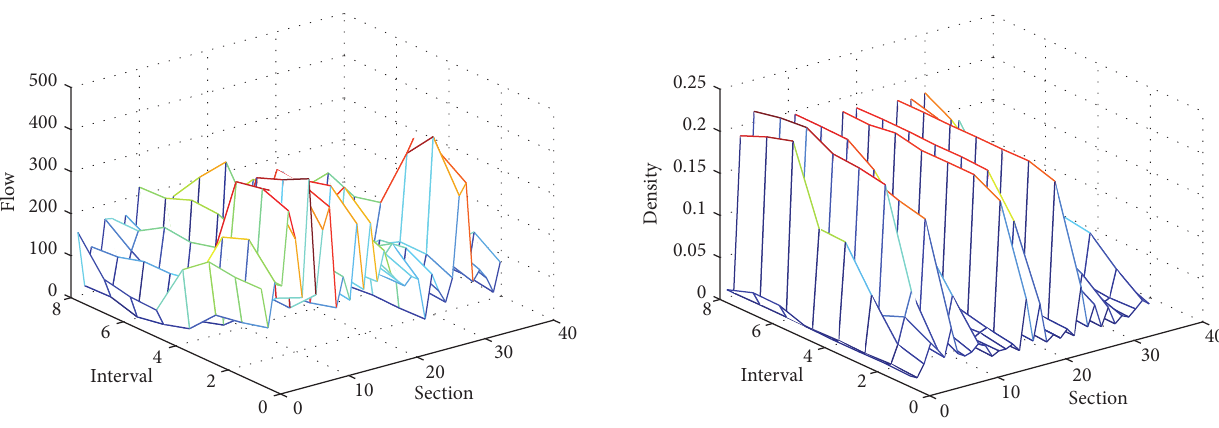
Figure 9: Averaged density after optimization.